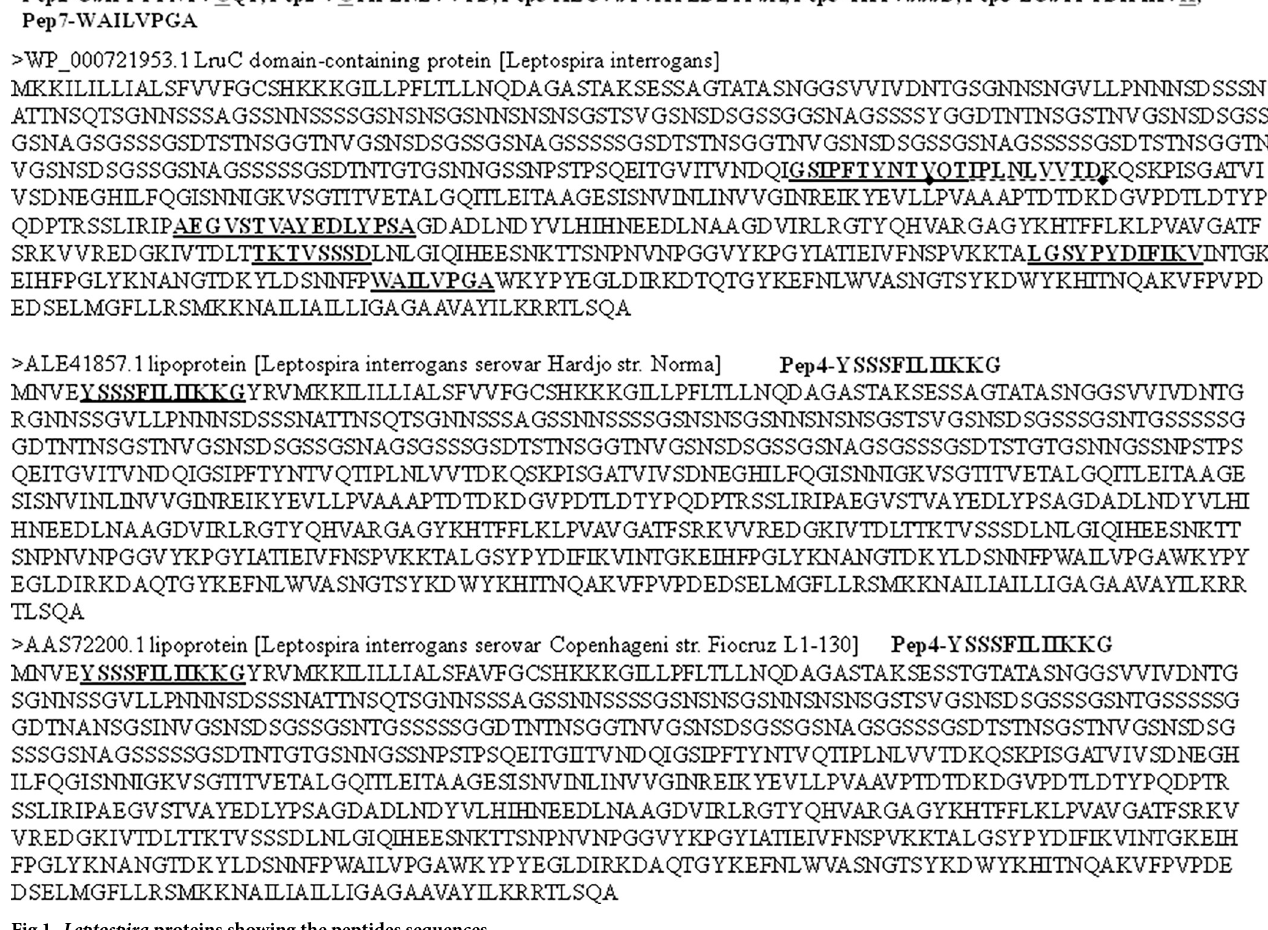
Fig 1. Leptospira proteins showing the peptides sequences.